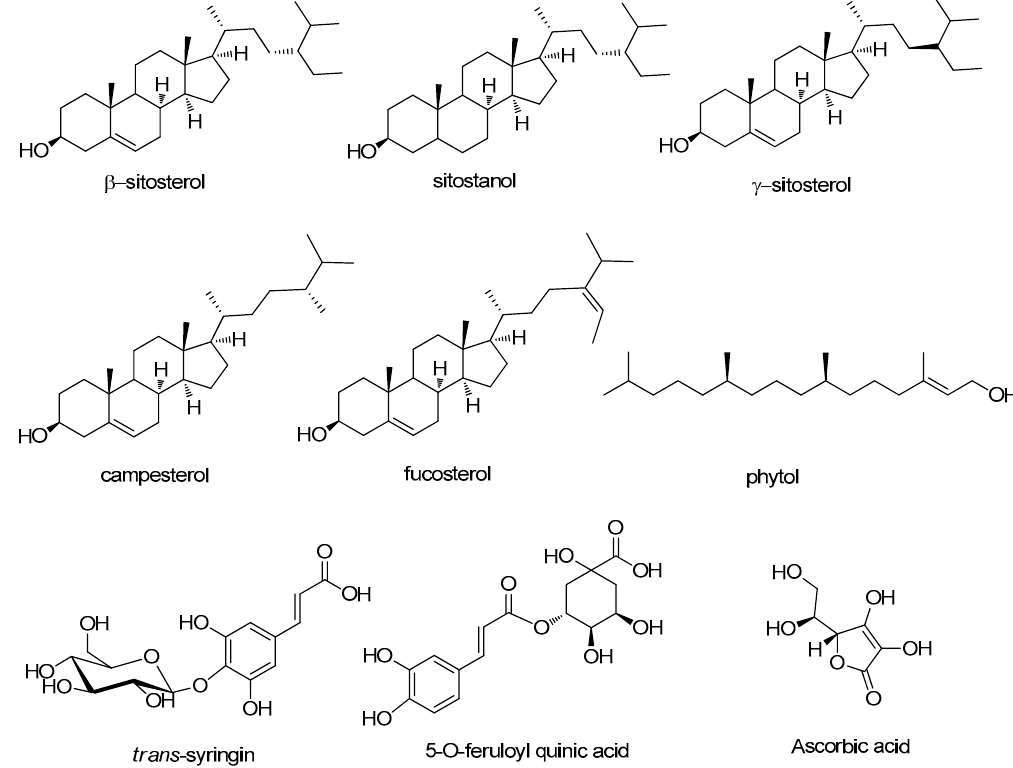
Figure 4. Structure of the most abundant constituents found in the G.diversifolia extract.